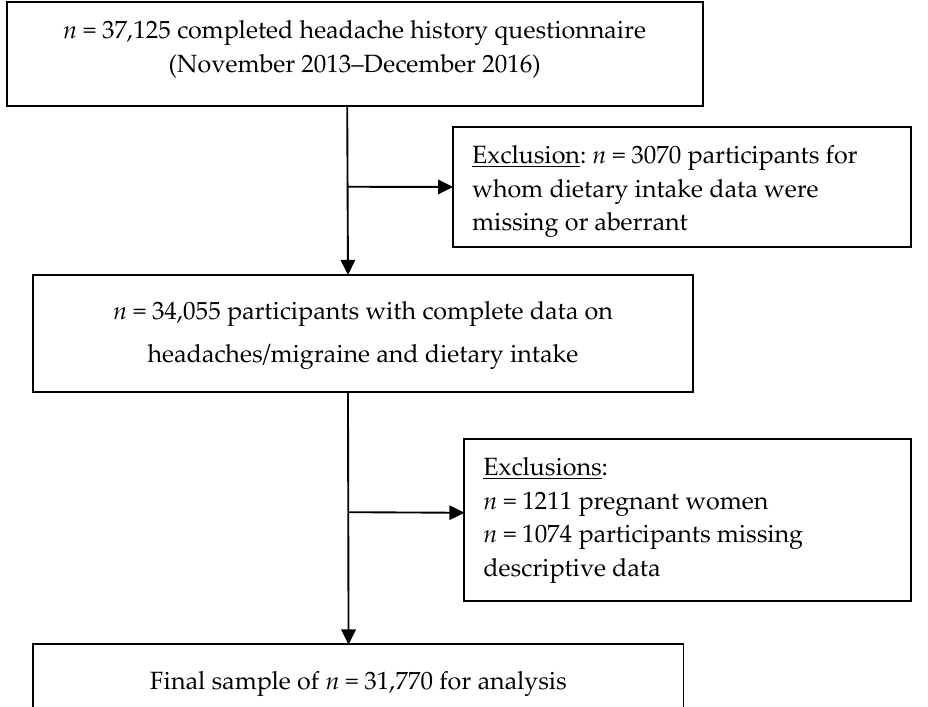
Figure 1. Participant selection flowchart.